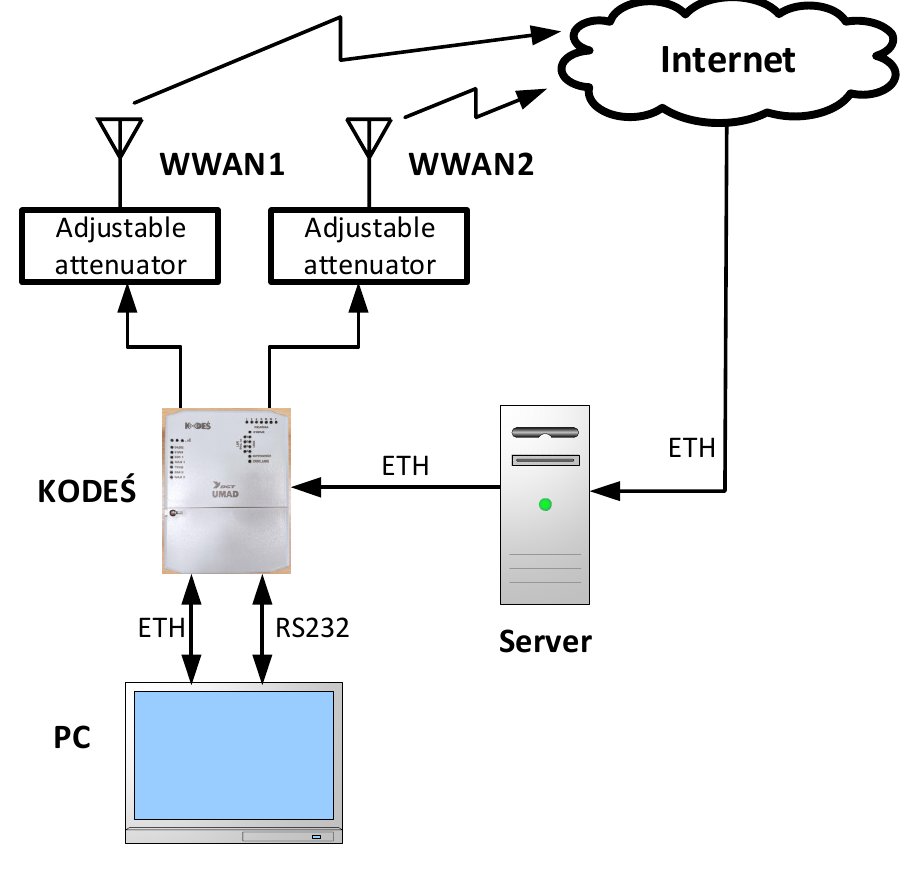
Figure 3. Laboratory